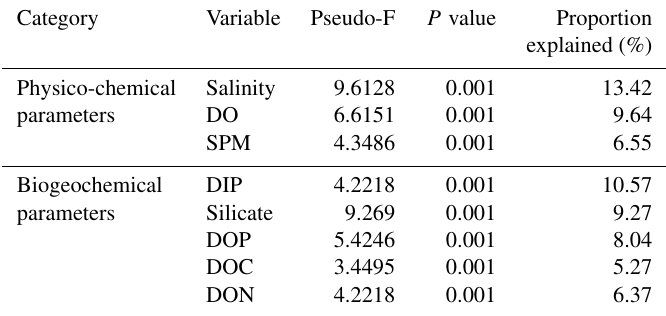
Table 3. Proportion of combined community variation based on marginal DistLM test that is explained by each predictor variable using two cruises (August and March